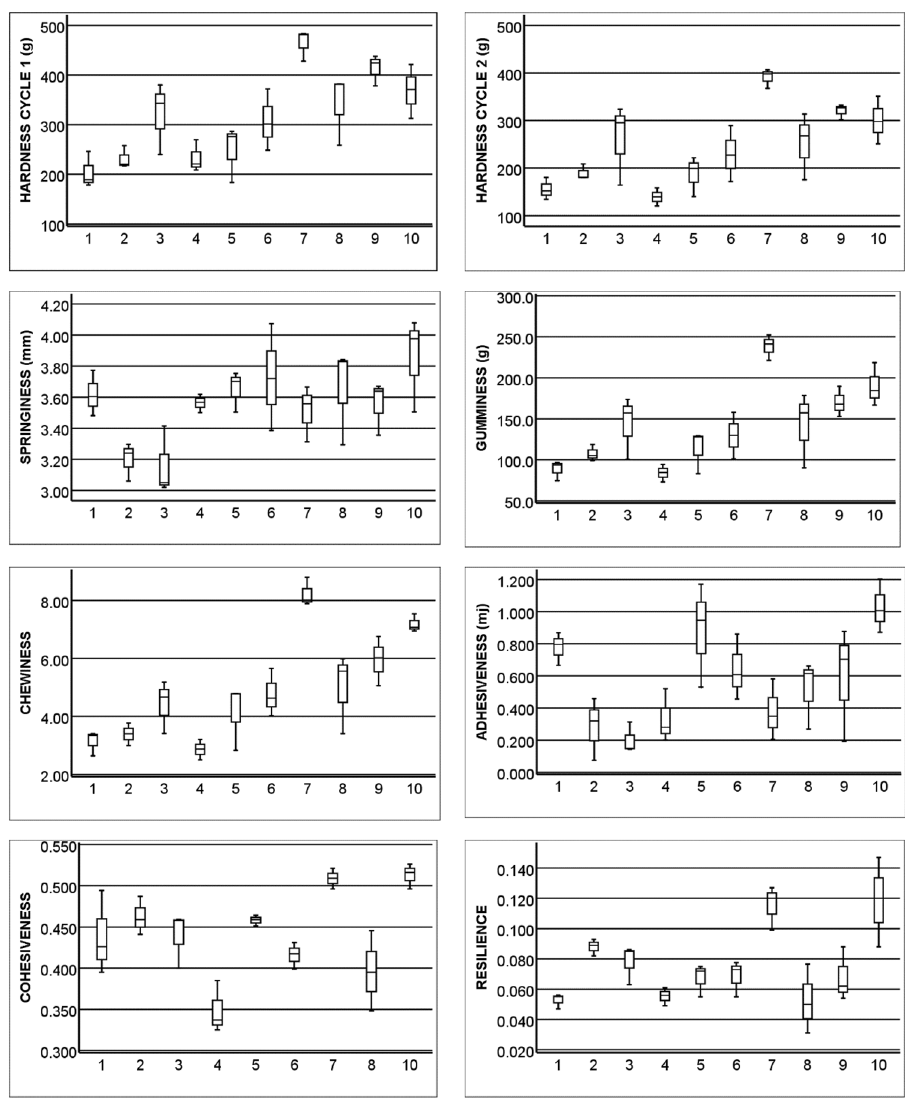
Figure 6. The variability of the texture parameters in the 10 studied date varieties: (1) Barhi, (2) Boumann, (3) Dabbas, (4) Fardh, (5) Khalas, (6) Lulu red, (7) Neghal, (8) Reziz, (9) Sagei, and (10) Shishi.